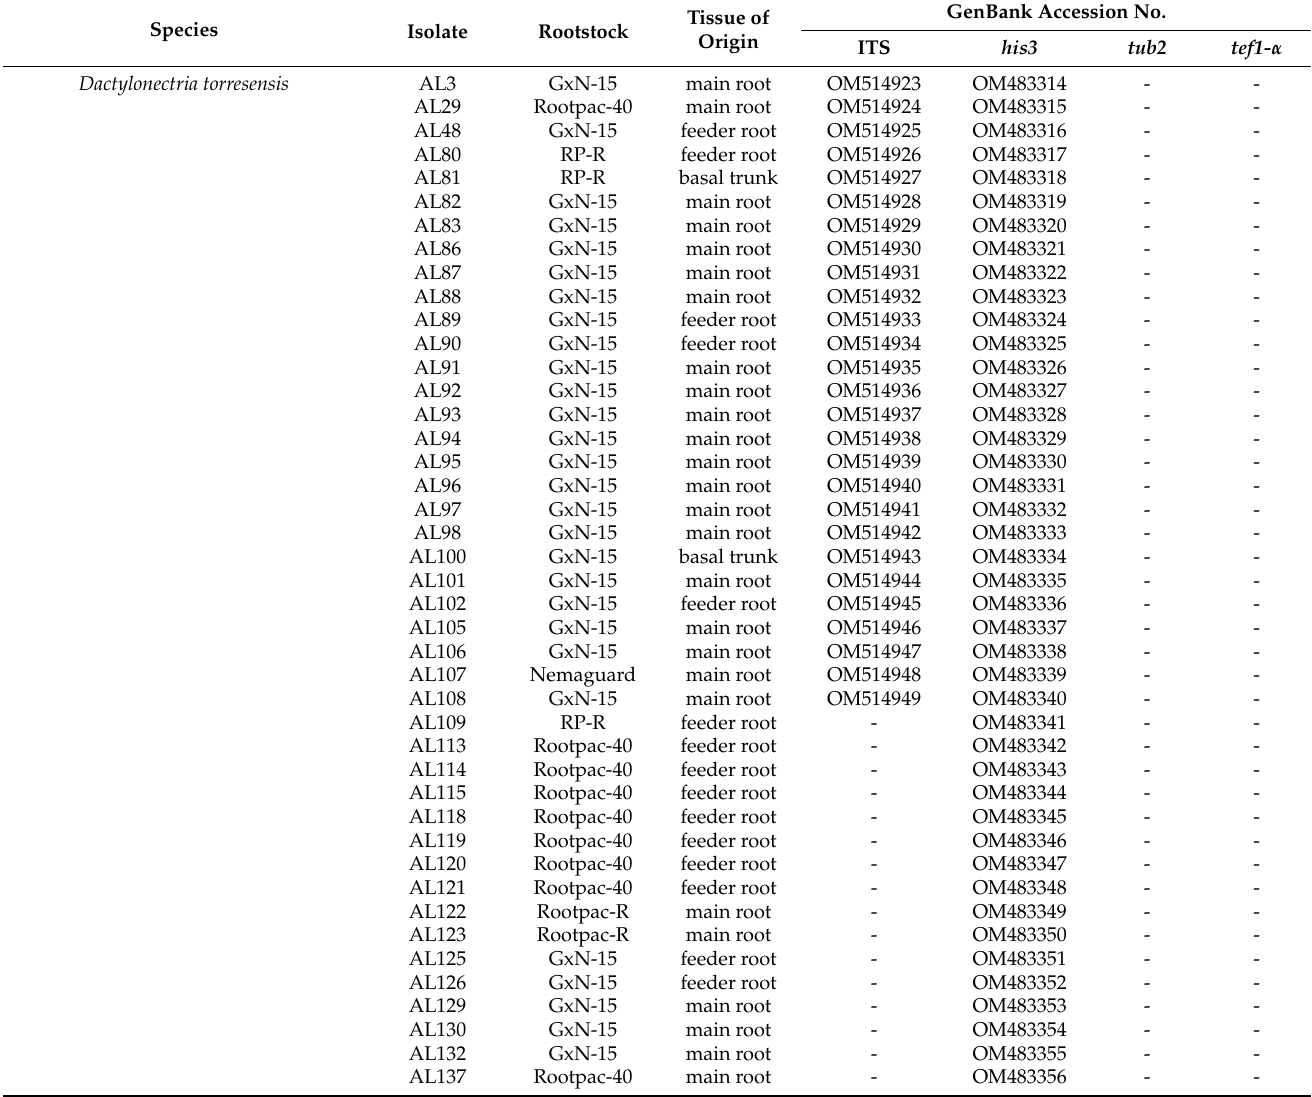
Table 1. Cylindrocarpon -like anamorphs used in this